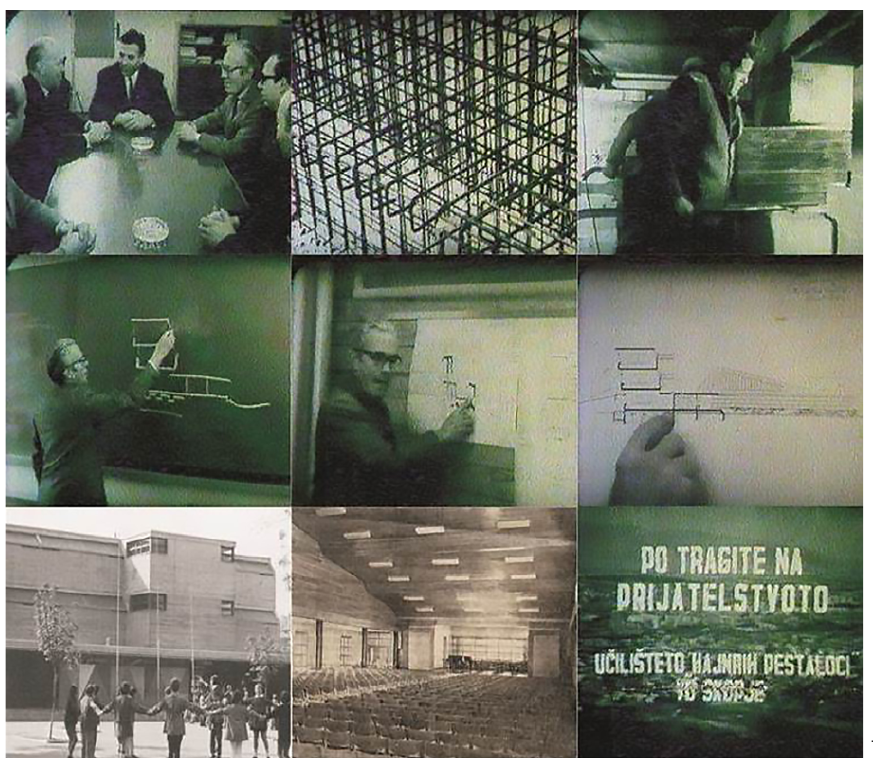
Fig. 7 Screen captures from the docu- mentary movie On the Traces of Friendship, Johann Hainrich Pestlozzi School in Skopje . Directed by Trajče Popov. Vardar Film,